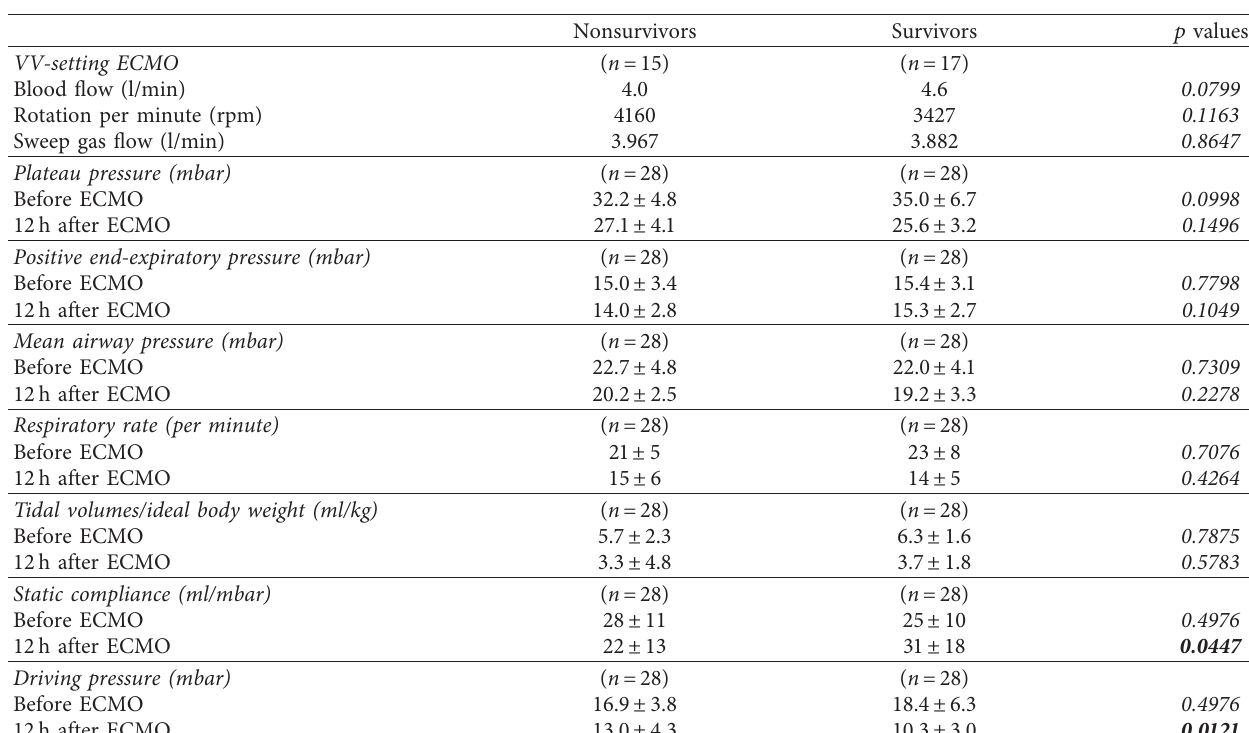
Table 4: Ventilator